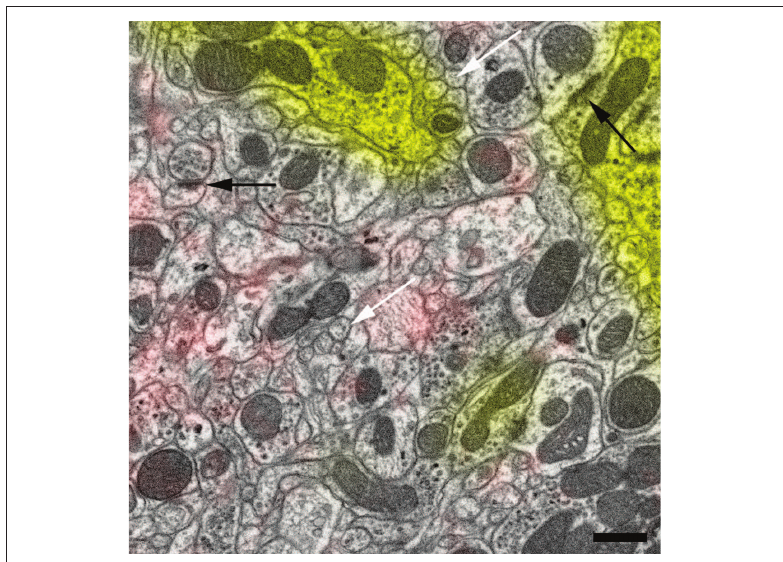
Figure 4 | Magnified view of the region in Figure 3C enclosed by the dashed square. The high-quality ultrastructure is illustrated by membranes of small neurites that have no gap artifacts and appear fully closed (white arrows) and by highly contrasted synaptic densities (black arrows). Scale bar 500